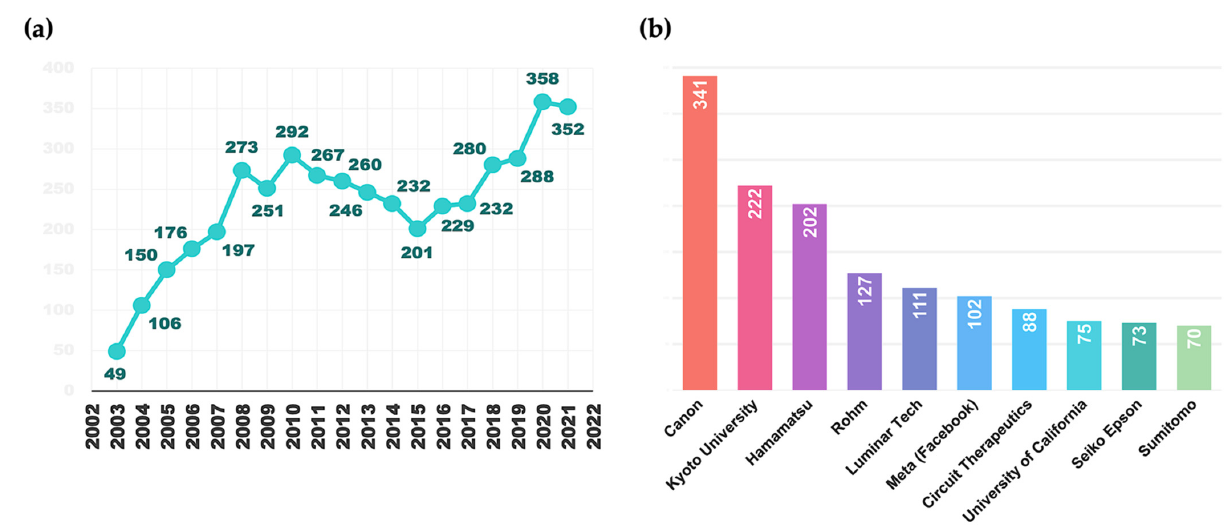
Figure 4. Overview of relevant patents retrieved from Derwent Innovation’s patent database. ( a ) The corresponding annual patent counts. ( b ) The top 10 PCSEL-relevant patent assignees.